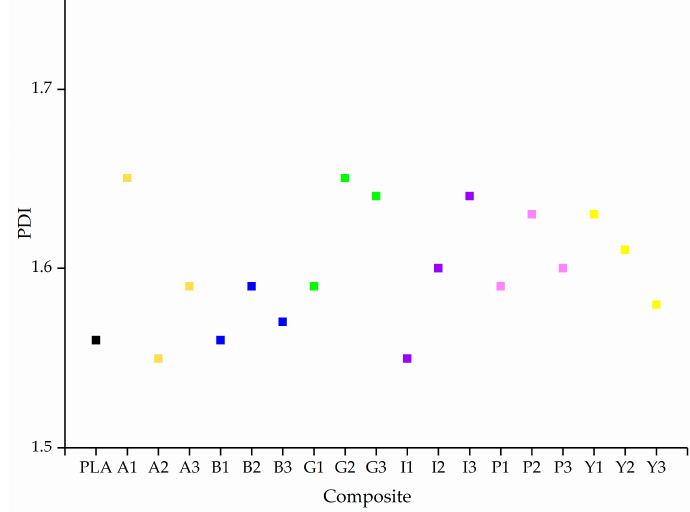
Figure 10. The weight average molecular weight (Mw) and number average molecular weight (Mn) of PLA and its composites containing 1%, 2% and 3% (w/w) of each additive.